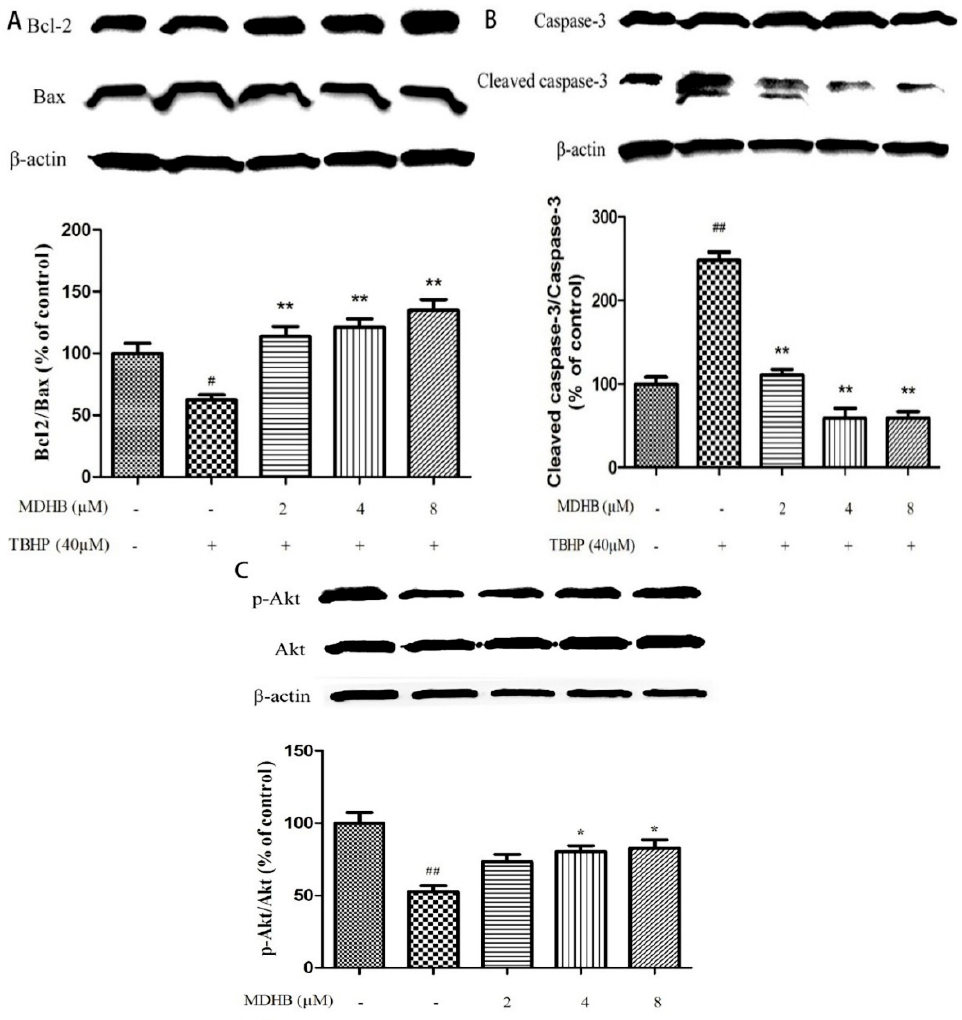
Figure 6. Effect of MDHB on Bcl2/Bax, cleaved caspase-3/pro-caspase-3, p-Akt/Akt expression in SH-SY5Y cells. Protein expression was estimated using Western blot. ( A ) Effect of MDHB on Bcl2/Bax expression in SH-SY5Y cells. The data are expressed as the mean ± S.EM. # p < 0.05 versus the control group. ** p < 0.01 versus the TBHP group ( n = 3); ( B ) Effect of MDHB on the expression of cleaved caspase-3/ pro-caspase-3 in SH-SY5Y cells. The data are expressed as the mean ± S.EM. ## p < 0.01 versus the control group. ** p < 0.01 versus the TBHP group ( n = 3); ( C ) Effect of MDHB on p-Akt/Akt expression in SH-SY5Y cells. The data are expressed as the mean ± S.EM. ## p < 0.01 versus control group, * p < 0.05 versus TBHP group ( n = 3).